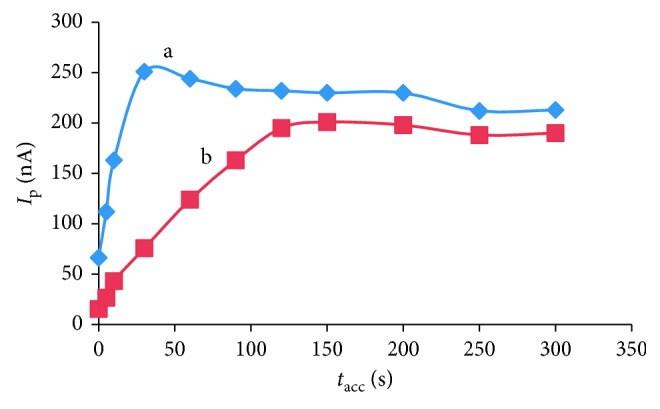
Effect of tacc on the peak current (Ip) of two different concentrations of AO: (a) 10−6 mol·L−1 and (b) 2.4 × 10−7 mol·L−1; Eacc = −0.5°V, scan rate 250 mV·s−1, f = 50 Hz.